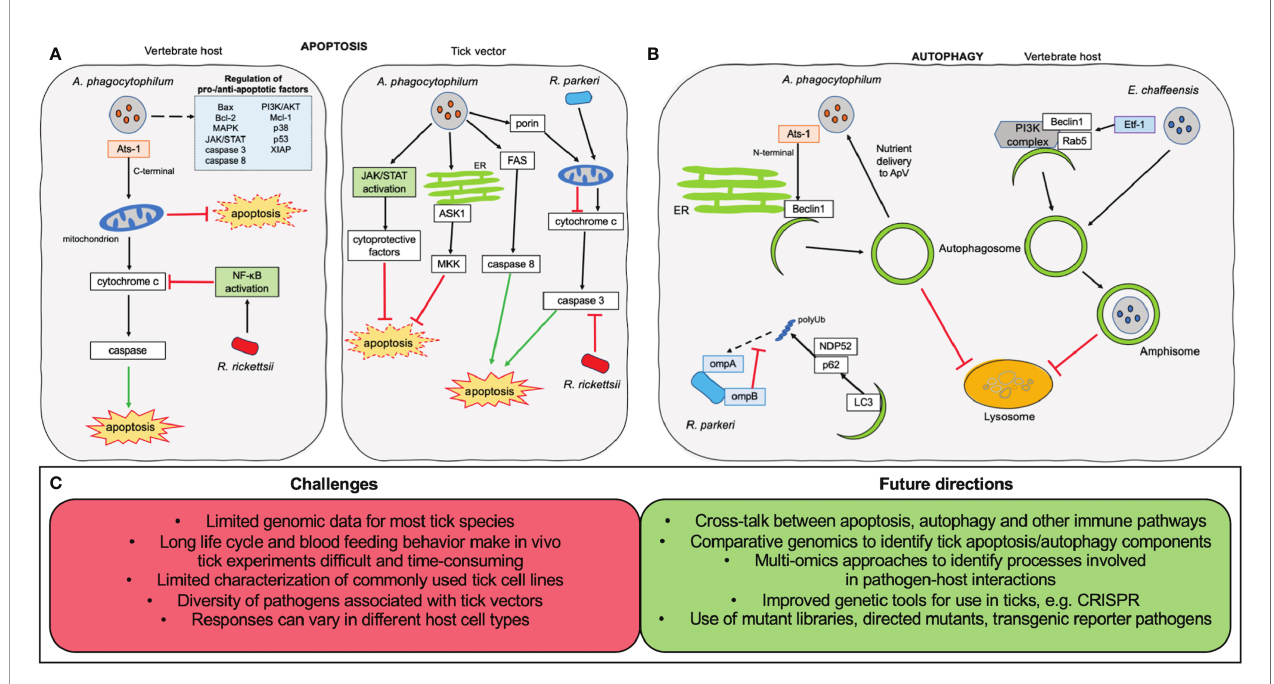
FIGURE 2 | Overview of apoptosis and autophagy research on tick-borne obligate intracellular pathogens. (A) Manipulation of apoptosis. In the vertebrate host (left) the C-terminal fragment of the Anaplasma phagocytophilum effector Ats-1 localizes to the host mitochondria where it inhibits apoptosis. A large number of kinases and pro-/anti-apoptotic factors (shown in pale blue box) also show changes in expression during A. phagocytophilum infection. Rickettsia rickettsii infection leads to NF- k B activation, inhibiting cytochrome c release from mitochondria resulting in downstream inhibition of apoptosis. In the tick vector (right), A. phagocytophilum uses multiple pathways to inhibit apoptosis, including activation of the JAK/STAT pathway, down-regulation of mitogen-activated protein kinase (MKK) and apoptosis signal-regulating kinase 1 (ASK1), decreasing FAS expression, and reducing porin expression to inhibit cytochrome c release from the mitochondria. Rickettsia rickettsii prevents caspase 3 activation in order to inhibit apoptosis. Rickettsia parkeri infection is associated with increased mitochondrial cytochrome c release, leading to increased activation of apoptosis, which is essential to its infection of tick cells. (B) Manipulation of autophagy. Experimental evidence only exists from mammalian systems. The N-terminal portion of the A. phagocytophilum effector Ats-1 localizes to the endoplasmic reticulum (ER) where it interacts with Beclin1 to initiate autophagosome formation. Autophagosomes are prevented from traf fi cking to the lysosome and instead fuse with the bacterial vacuole to deliver membrane and nutrients to A. phagocytophilum. The Etf-1 effector secreted by Erhlichia chaffeensis interacts with Beclin1, Rab5 and the PI3K complex to induce autophagosome formation. The autophagosomes fuse with the Erhlichia- containing vacuole and are prevented from fusing with the lysosome by bacterial interference with the Wnt signalling pathway. During R. parkeri infection of macrophages, ompB shields the rickettsial surface protein ompA from polyubiquitination, preventing its recognition by the autophagy adaptors p62 and NDP52. (C) Challenges and future directions in the research of interactions of intracellular tick-borne pathogens with apoptosis and autophagy